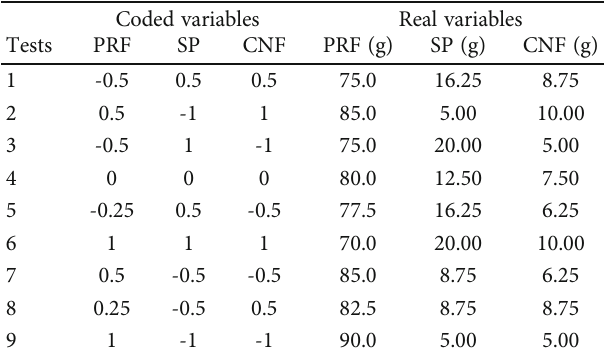
Table 1: Experimental matrix. Coded